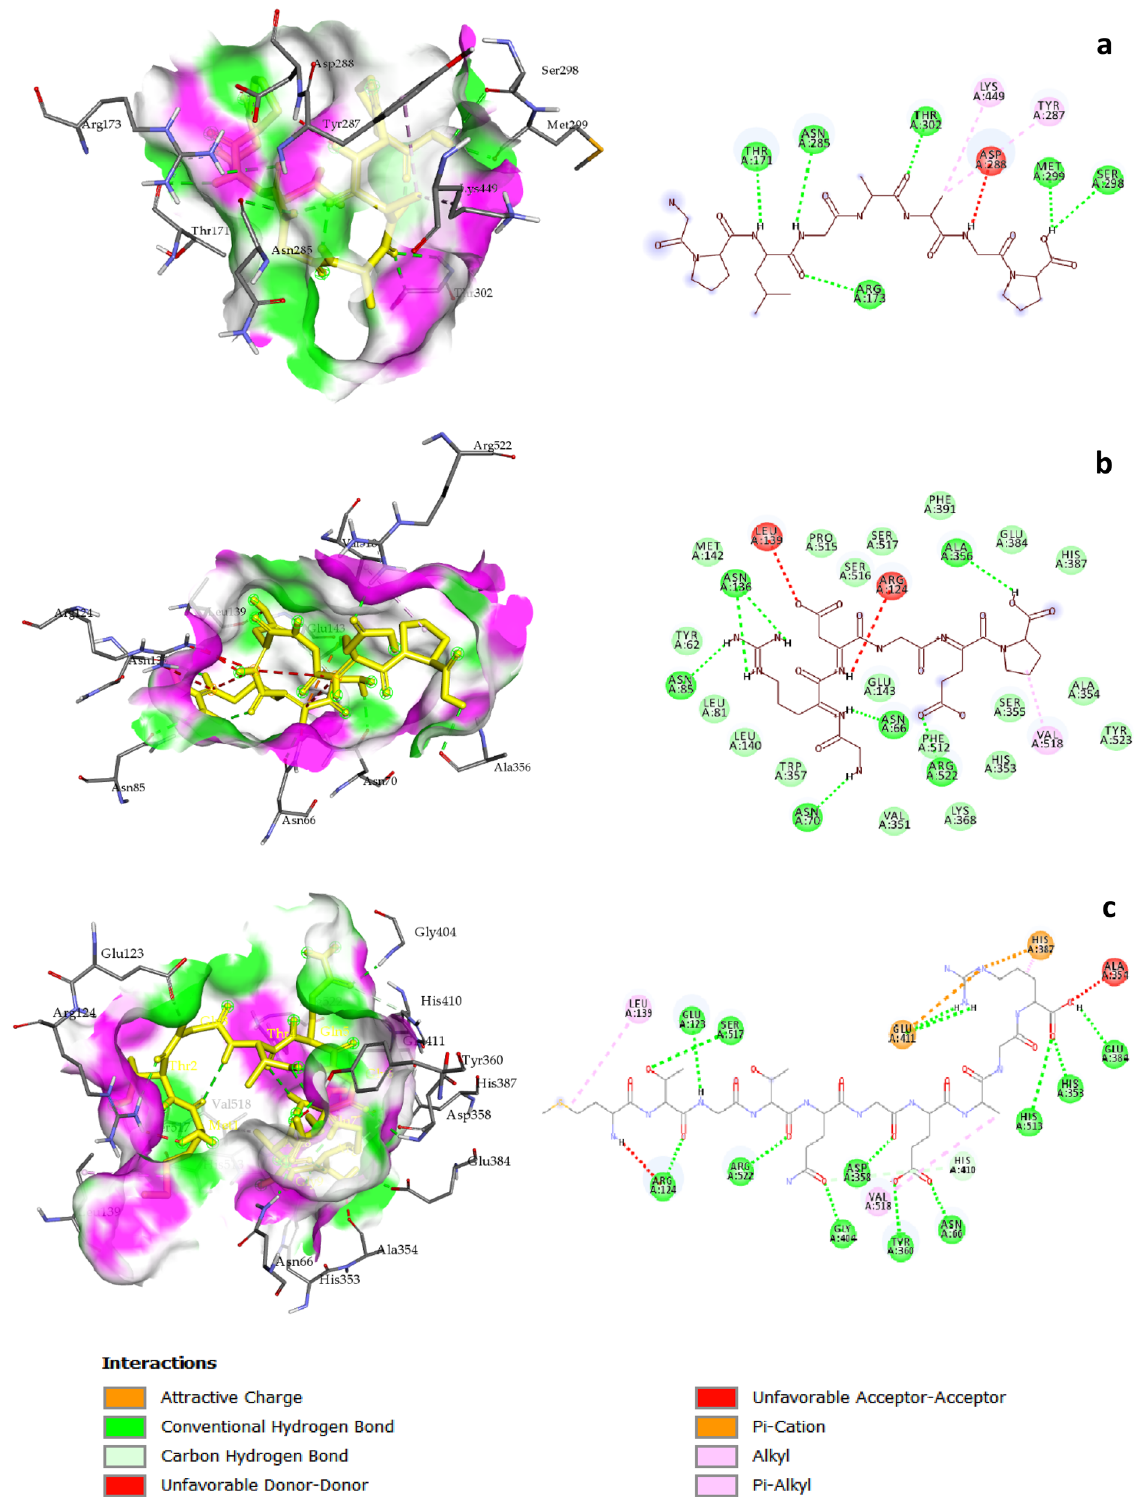
Figure 5. Computational simulation of the docked peptides on the human angiotensin-converting enzyme (ACE) structure with their interactions. ( a ) GPLGAAGP (P1), ( b ) GRDGEP (P2), and ( c ) MTGTQGEAGR